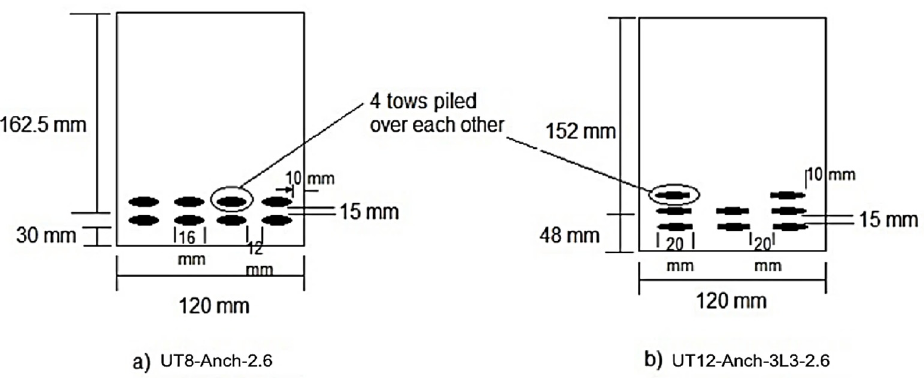
Figure 17. Details of reinforcements of UT 8 -Anch-2.6 and UT 12 -Anch-3L 3 -2.6 TRC beams. Table 9. Outcomes of TRC beams having the same cross-section area and various layers.